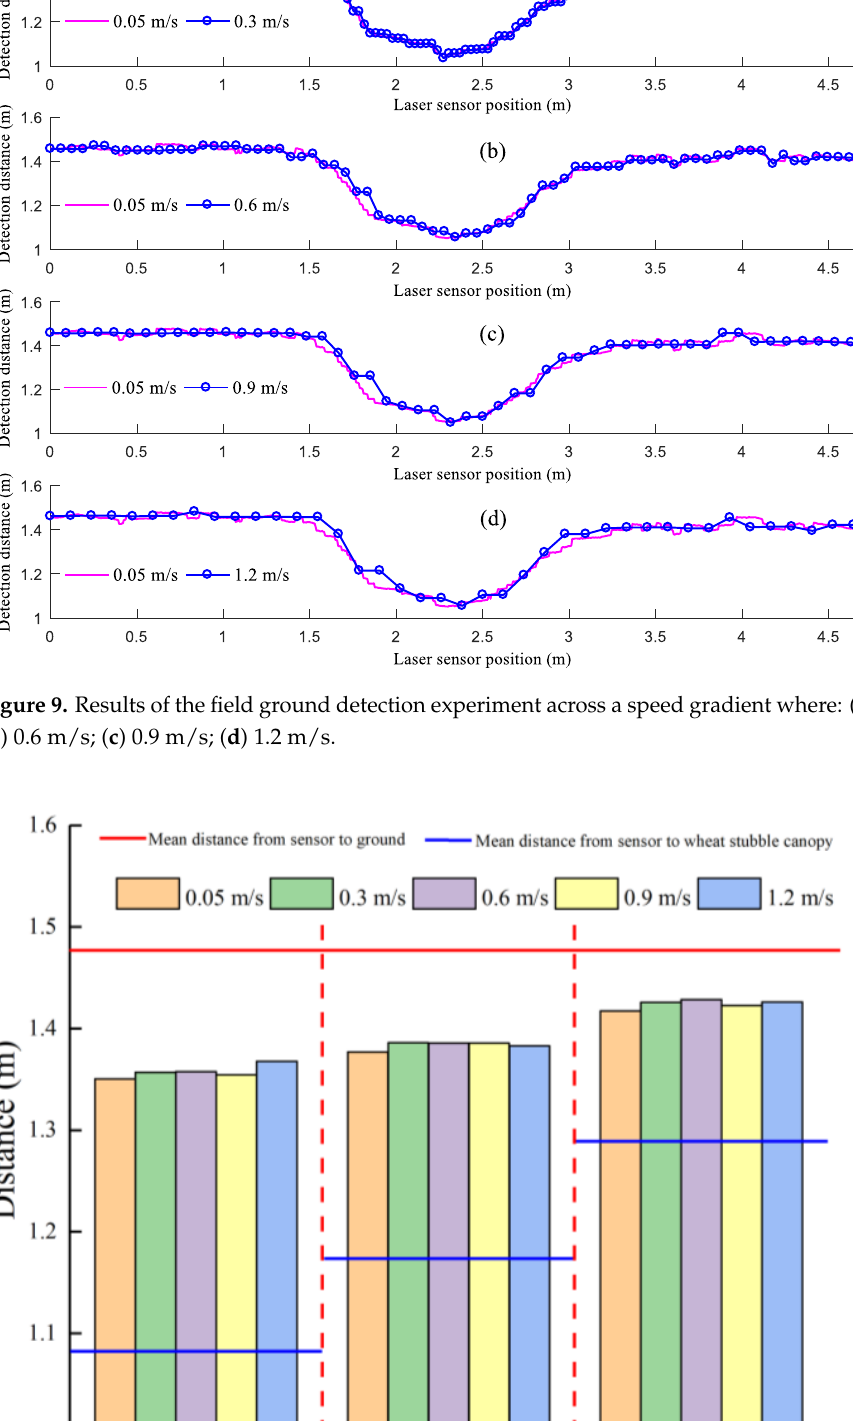
Figure 9. Results of the field ground detection experiment across a speed gradient where: ( a ) 0.3 m/s; ( b ) 0.6 m/s; ( c ) 0.9 m/s; ( d ) 1.2 m/s.